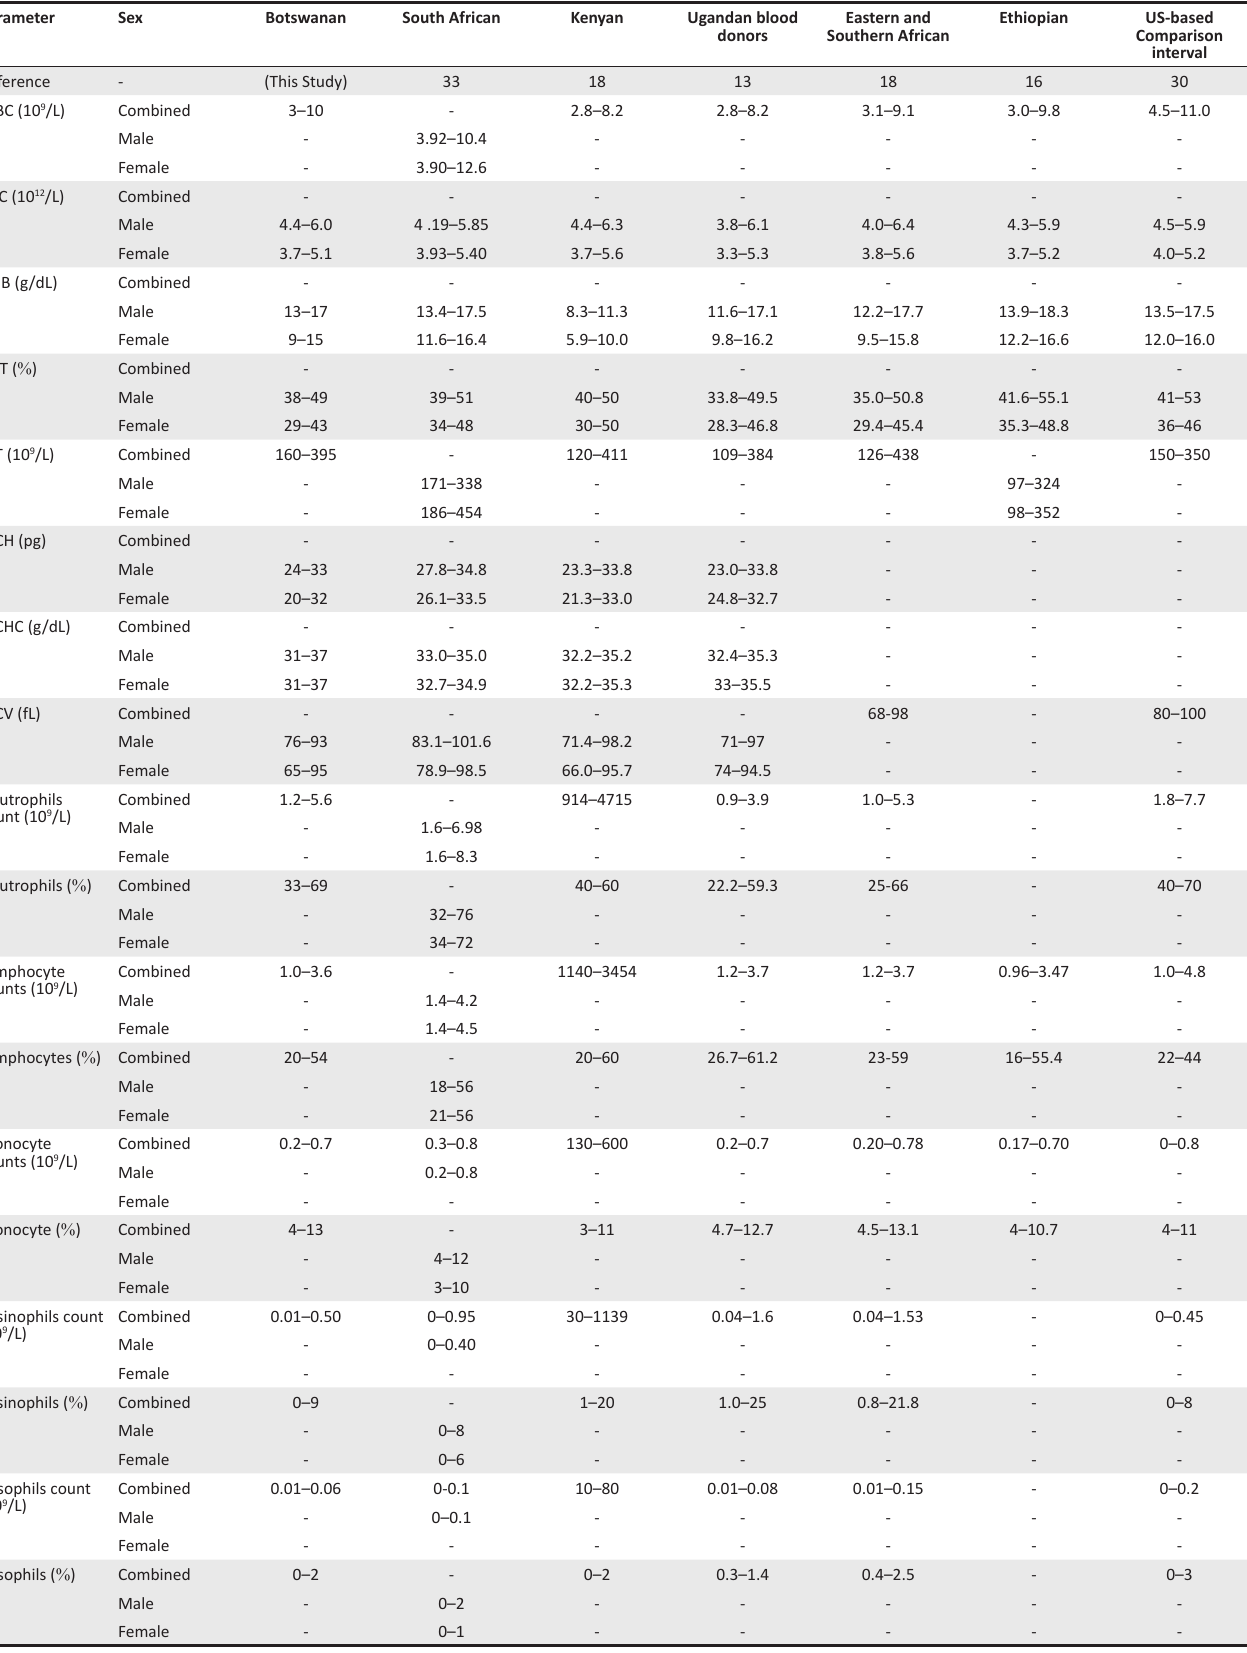
TABLE 7: Comparison of haematological parameters between different populations.